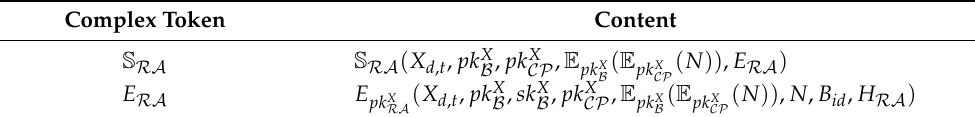
Table 2. Complex tokens used by the proposed protocol.